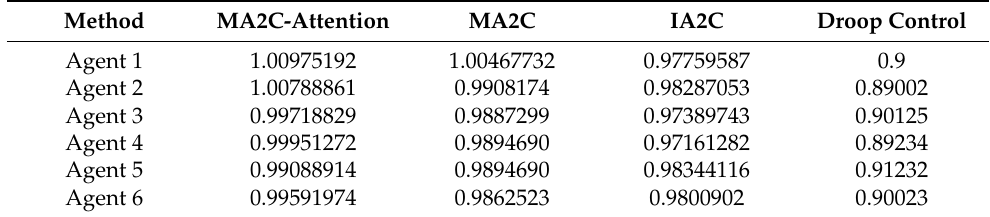
Table 2. Voltage value under different